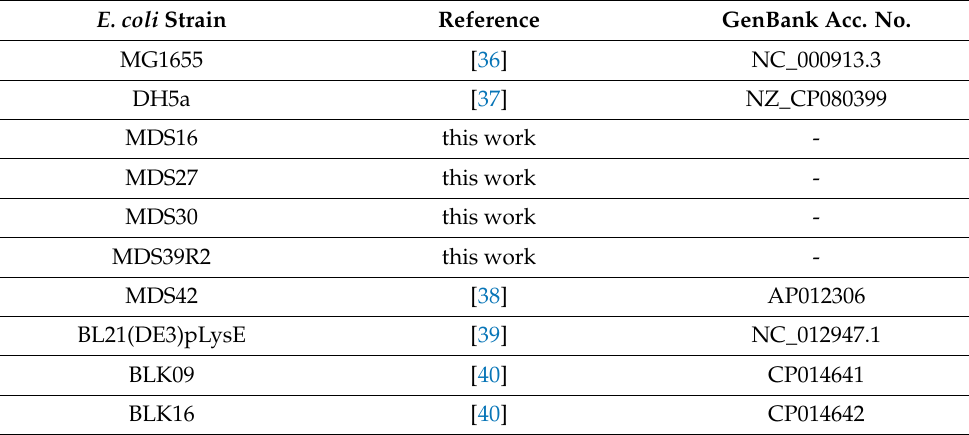
Table 1. E. coli strains modified in this